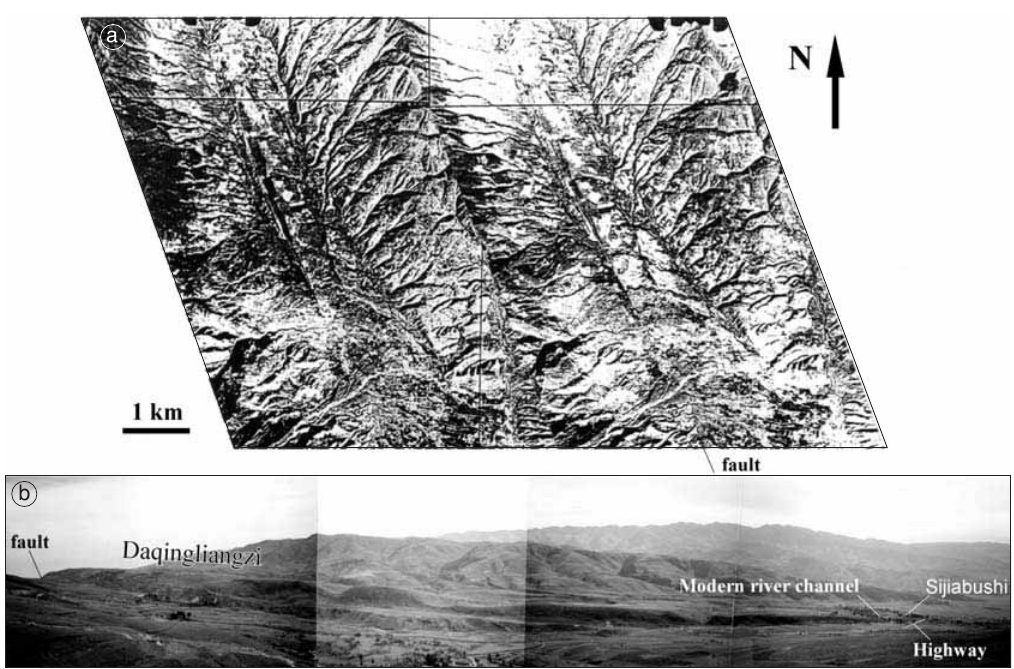
Fig. 4a,b. 5 km long fault scarp from Daqing to Sijiabushi (location shown in fig. 2). a) A pair of air photo- graphs; b) field photograph, view to